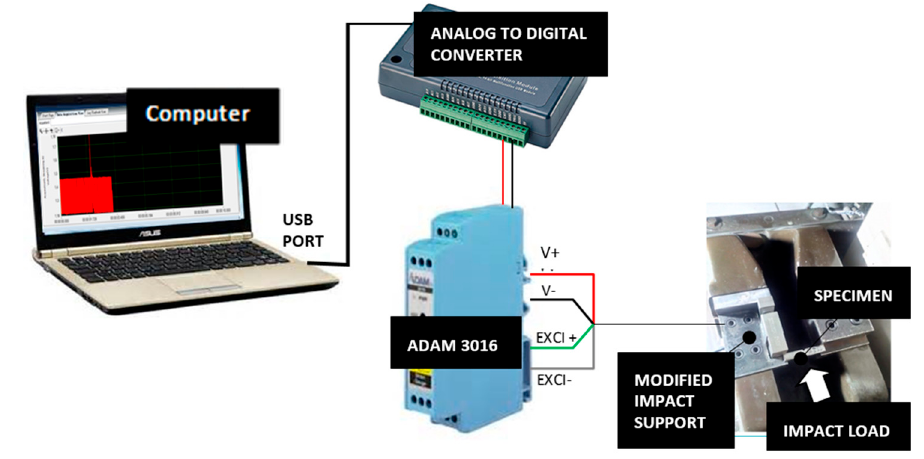
Figure 4. High-speed sampling rate data acquisition instrument.